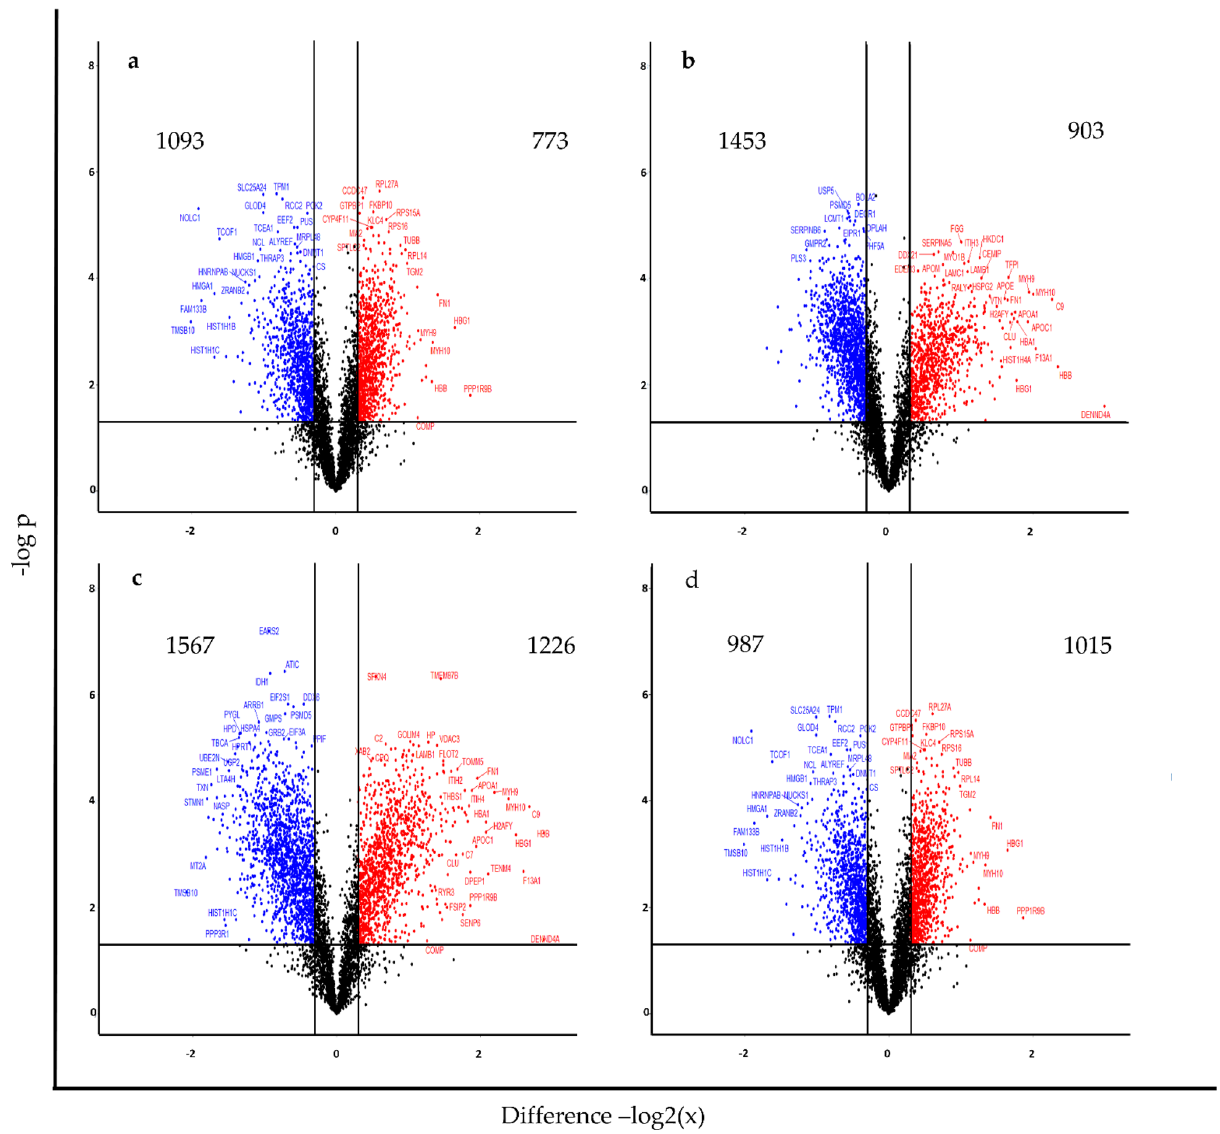
Figure 2. Volcano plots indicating significant differences in proteins between experimental groups identified using a two-sided t-test allowing for 250 randomisations, an FDR of 0.05 and mean fold change of log2(x) ± 0.3 for ( a ) D14C verses D0C, ( b ) D21C verses D0C, ( c ) D28C verses D0C, and ( d ) D28C verses D14C. Figure generated using RStudio software loaded with the ggplot package 30,31